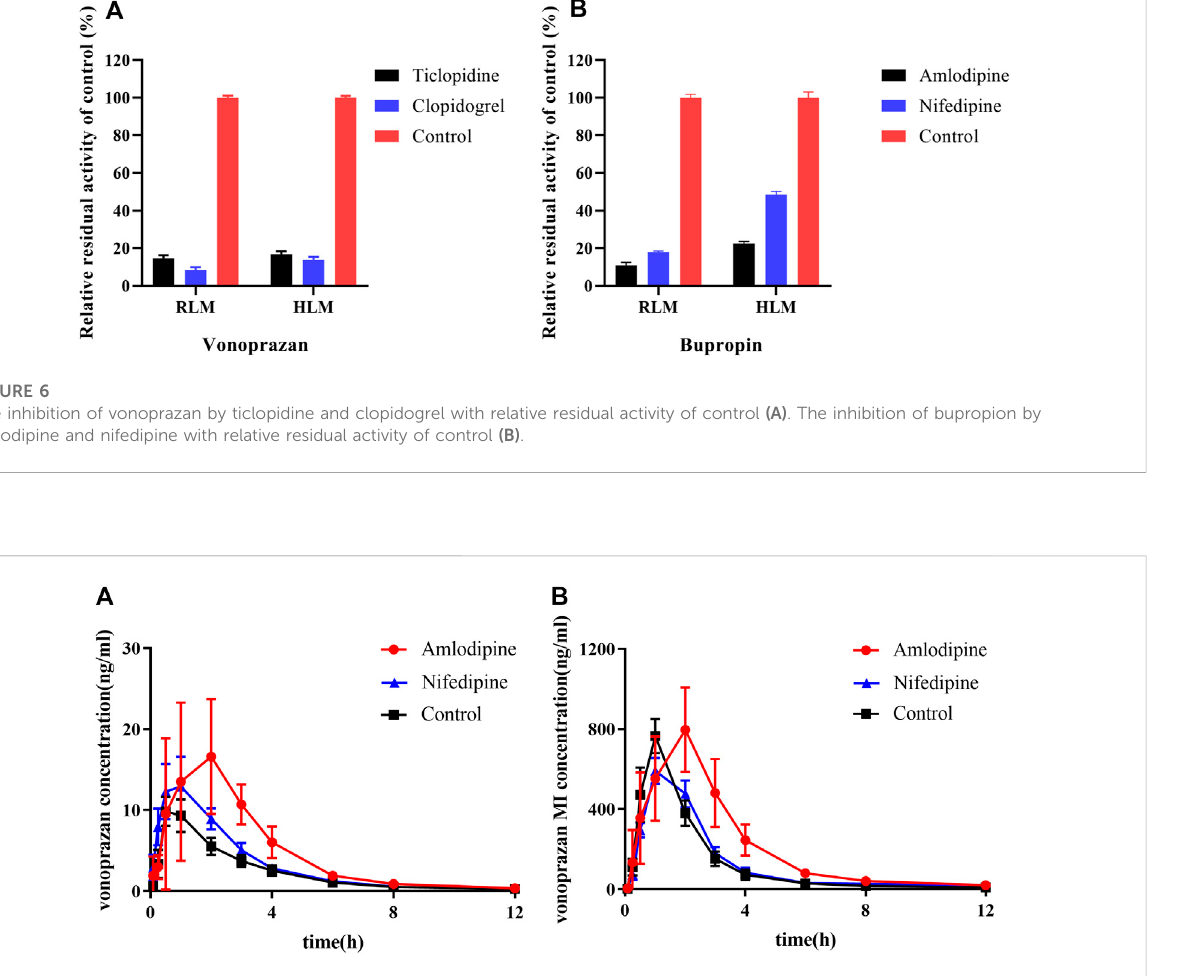
FIGURE 7 Mean plasma concentration – time curves of vonoprazan prototype and metabolite MI in amlodipine, nifedipine, and control groups. (A) Mean plasma concentration – time curves of vonoprazan prototype in control and amlodipine groups. (B) Mean plasma concentration – time curves of vonoprazan metabolite MI in control and amlodipine groups ( n =